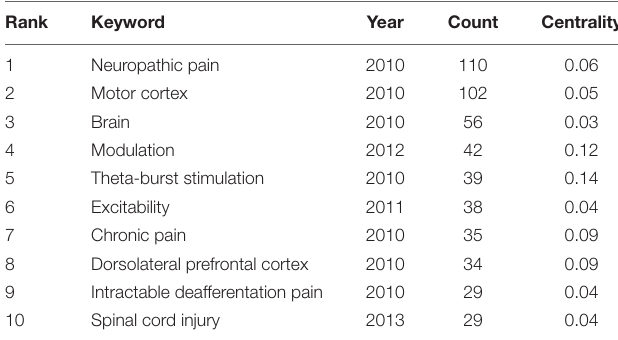
TABLE 3 | Ten representative keywords of TMS in pain research from 440 included